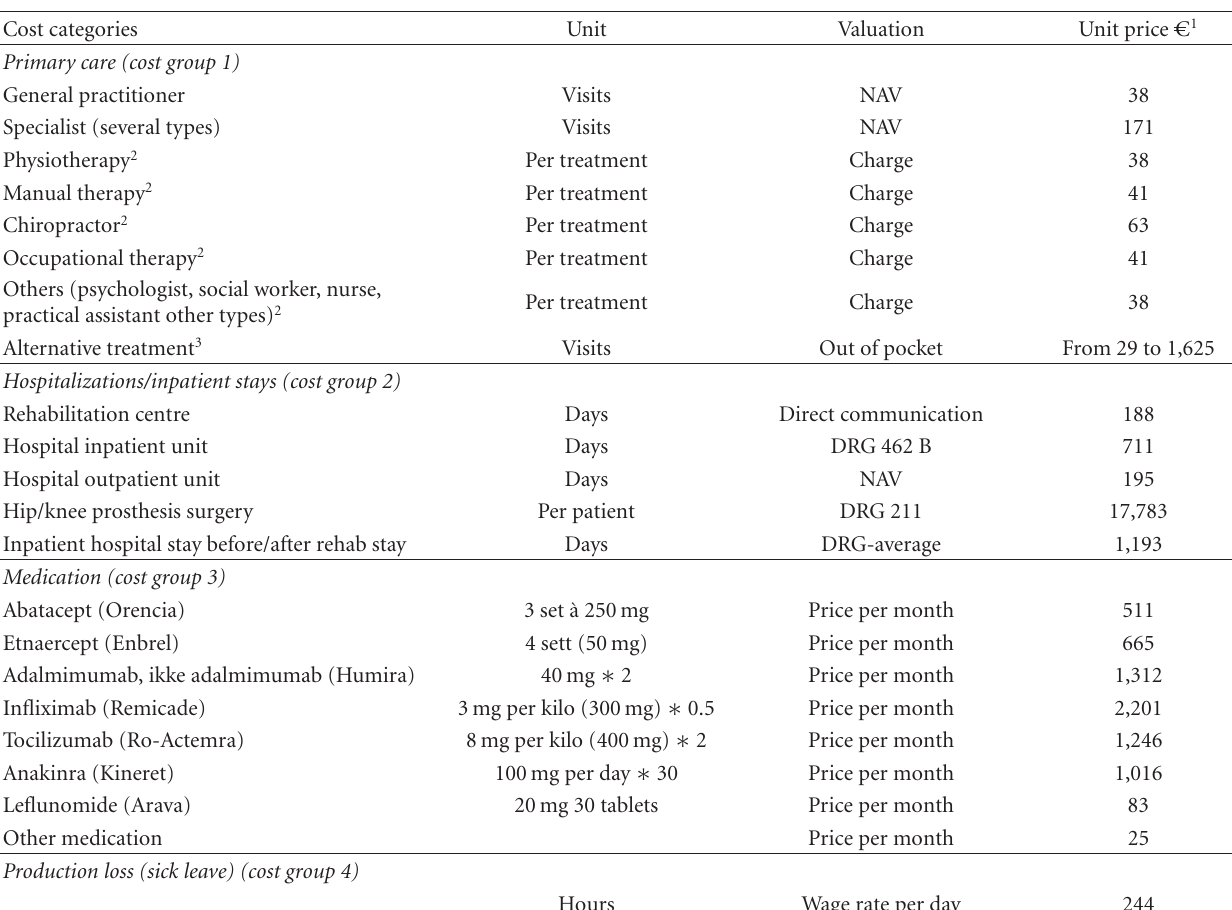
Table 1: Cost categories, units, valuation, and unit price, all numbers in EURO